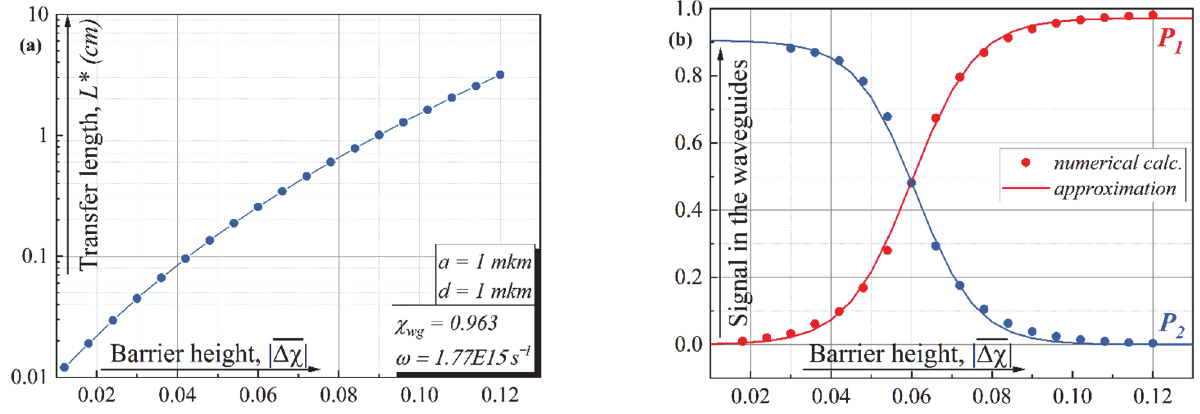
Figure 2. ( a ) The transfer length between the waveguides versus the “height of the barrier”. ( b ) The signal in the first/second waveguide (that is, the integral of the field energy in the corresponding region) versus the “height of the barrier”—dots, and the approximations of the results by sigmoidal functions—lines .